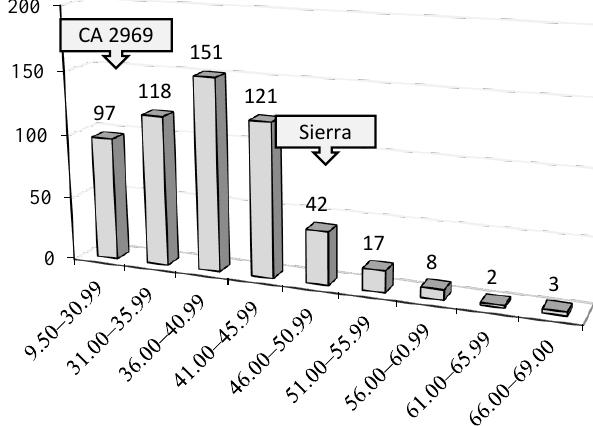
Figure 2. Distribution of F 2 progeny derived from intraspecific crosses between Sierra (single-podded